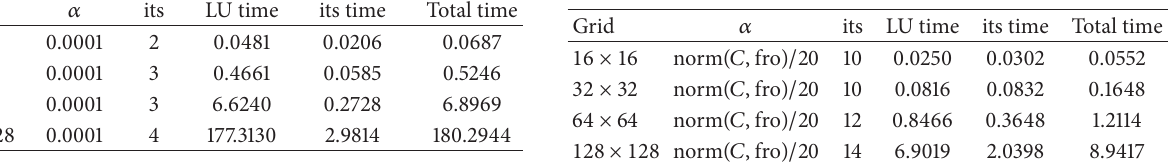
Table 4: Preconditioned GMRES(20) on steady Oseen problems with different grid sizes (uniform grids), viscosity V = 0.001 .